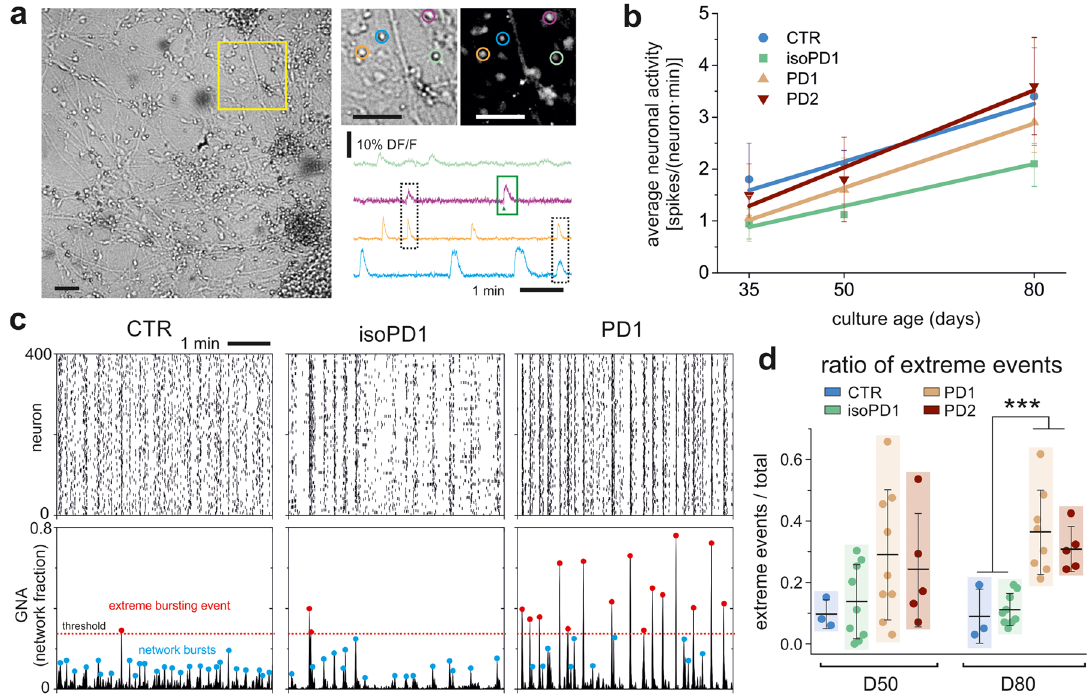
Fig. 2 Network dynamics of vmDA neurons. a Representative image of a bright fi eld recording at D80 (isoPD1) using the calcium imaging assay. Scale bar is 100 μ m. Regions of interest were manually selected for each neuron (diameter 10 μ m; color circles) to obtain the normalized calcium fl uorescence time series of spontaneous activity, DFF (%) (cid:1) 100 (cid:3) ð F (cid:4) F 0 Þ = F 0 , with F 0 the fl uorescence signal of the neuron at rest. The green box illustrates the fast rise of fl uorescence upon activation that procures the spiking onset time (arrowhead). The dashed black boxes illustrate coordinated neuronal activity that shape network bursts when several neurons are involved. b Average neuronal activity along maturation for the different cell lines. Data points are expressed as mean±SD. Trend lines are linear regressions. The number of cultures used in each condition and timepoint were: D35 (CTR: n = 3; isoPD1: 3; PD1: 4; PD2: 4); D50 (3; 9; 9; 5); D80 (3; 9; 8; 5). c Representative raster plots (top) and global network activity (GNA, bottom) for CTR (SP11), isoPD1, and PD1 (SP12) neuronal cultures at D80. Each plot shows 5 min of recording. Peaks in the GNA reveal network bursts (blue dots). Extreme bursting events (red dots) are those that are above a threshold (red dotted line) set as 95% con fi dence interval of CTR bursts ’ distribution. CTR and isoPD1 networks show a relative low percentage of extreme events, which contrasts with the rich abundance of them in PD1 networks. d Ratio of extreme events for all studied cell lines at D50 and D80. The colored boxes are a guide to visualize the distributions, which show the mean ± SD and the individual realizations (dots). For panels ( b ) and ( d ), the number of independent experiments for each condition and timepoint are D35 (CTR: n = 3, isoPD1: 3, PD1: 4, PD2: 4); D50 (3, 9, 9, 5); D80 (3, 9, 8, 5). *** p < 0.001 (ANOVA with multiple comparison